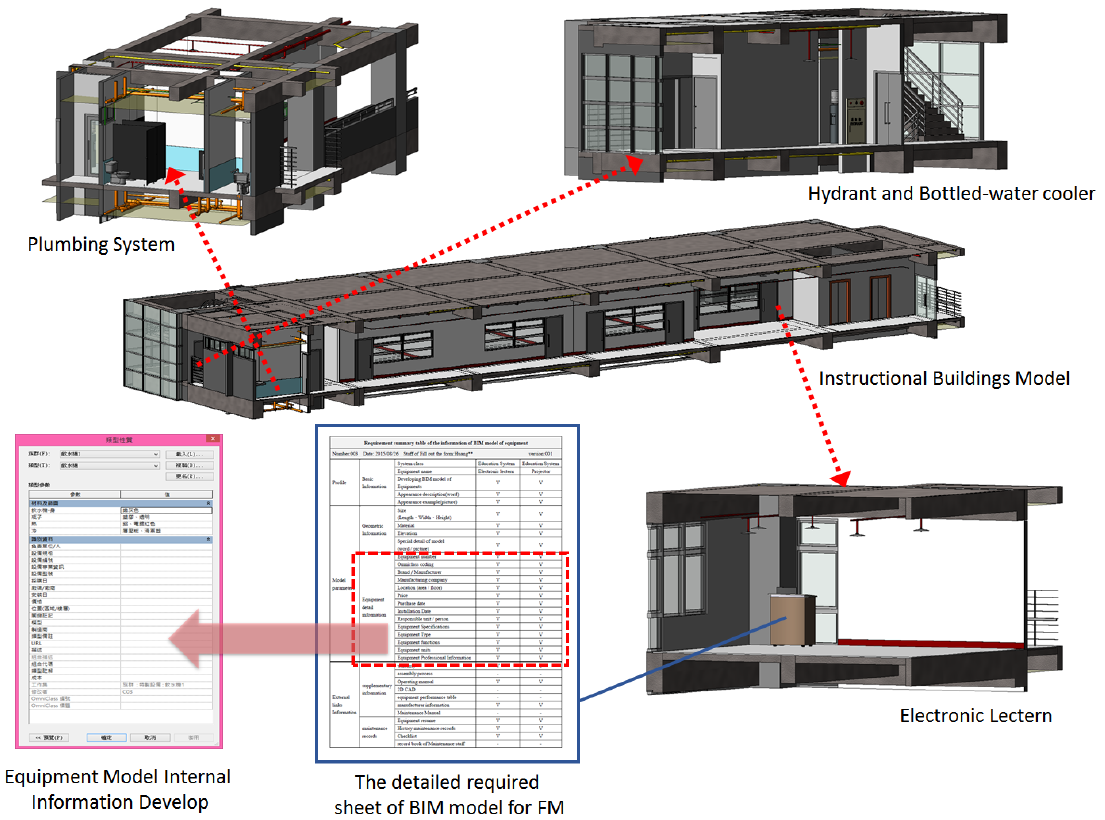
Figure 6. The use of detailed required sheet of BIM model for FM used in the case study.